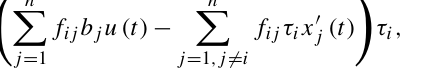
Figure 3. Seasonal cycles of the C storage capacity and C storage dynamics for the litter pool (i.e., pool 4 as shown in Fig. 1). All the components are shown to calculate x c , 4 ,u (t) = x c , 4 ,u (t) is the maximal amount of C that can transfer from C input to the litter pool. x c , 4 , p (t) is the maximal amount of C that can transfer from all the other pools to the litter pool. This figure is to illustrate the network of pools through which C is